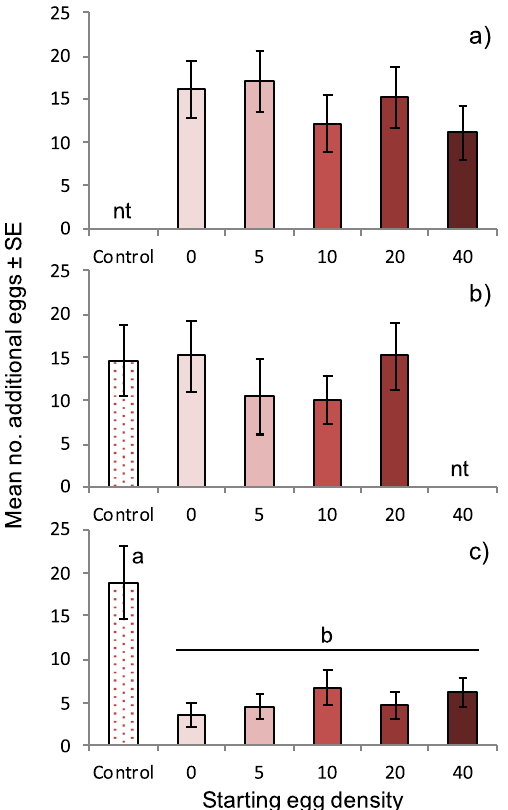
Figure 1. Female D. suzukii prefer to oviposit in unmarked substrates. Mean ± SE number of eggs oviposited per dish on a highly preferred raspberry juice-agar substrate in multi-choice assays. All dishes, except Control dishes, were exposed to adult D. suzukii for 2 h before the assay, and the starting egg density (per dish) was achieved by removing or adding eggs to dishes before the assay began. ‘Control’ is an unmarked, unoccupied dish. ‘nt’ = treatment was not tested. ( a ) All substrates were marked by adult D. suzukii , ( b ) All substrates were unmarked, but contained eggs if applicable (eggs were transferred from a marked to unmarked dish using sterile forceps), ( c ) Substrates except for the Control were marked by adult D. suzukii . Values sharing the same letter are not significantly different (alpha =